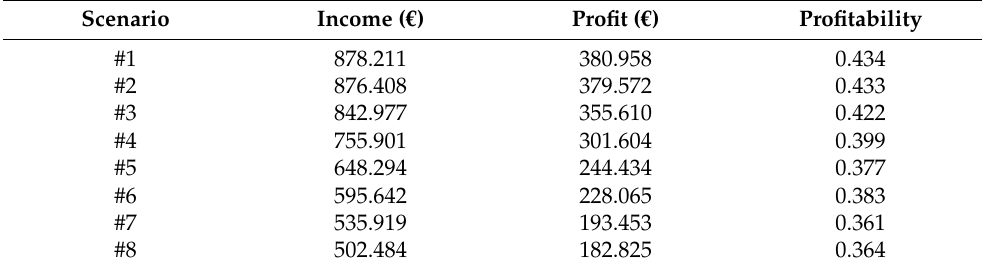
Table 7. Income, profit, and profitability for the various scenarios for 14 August